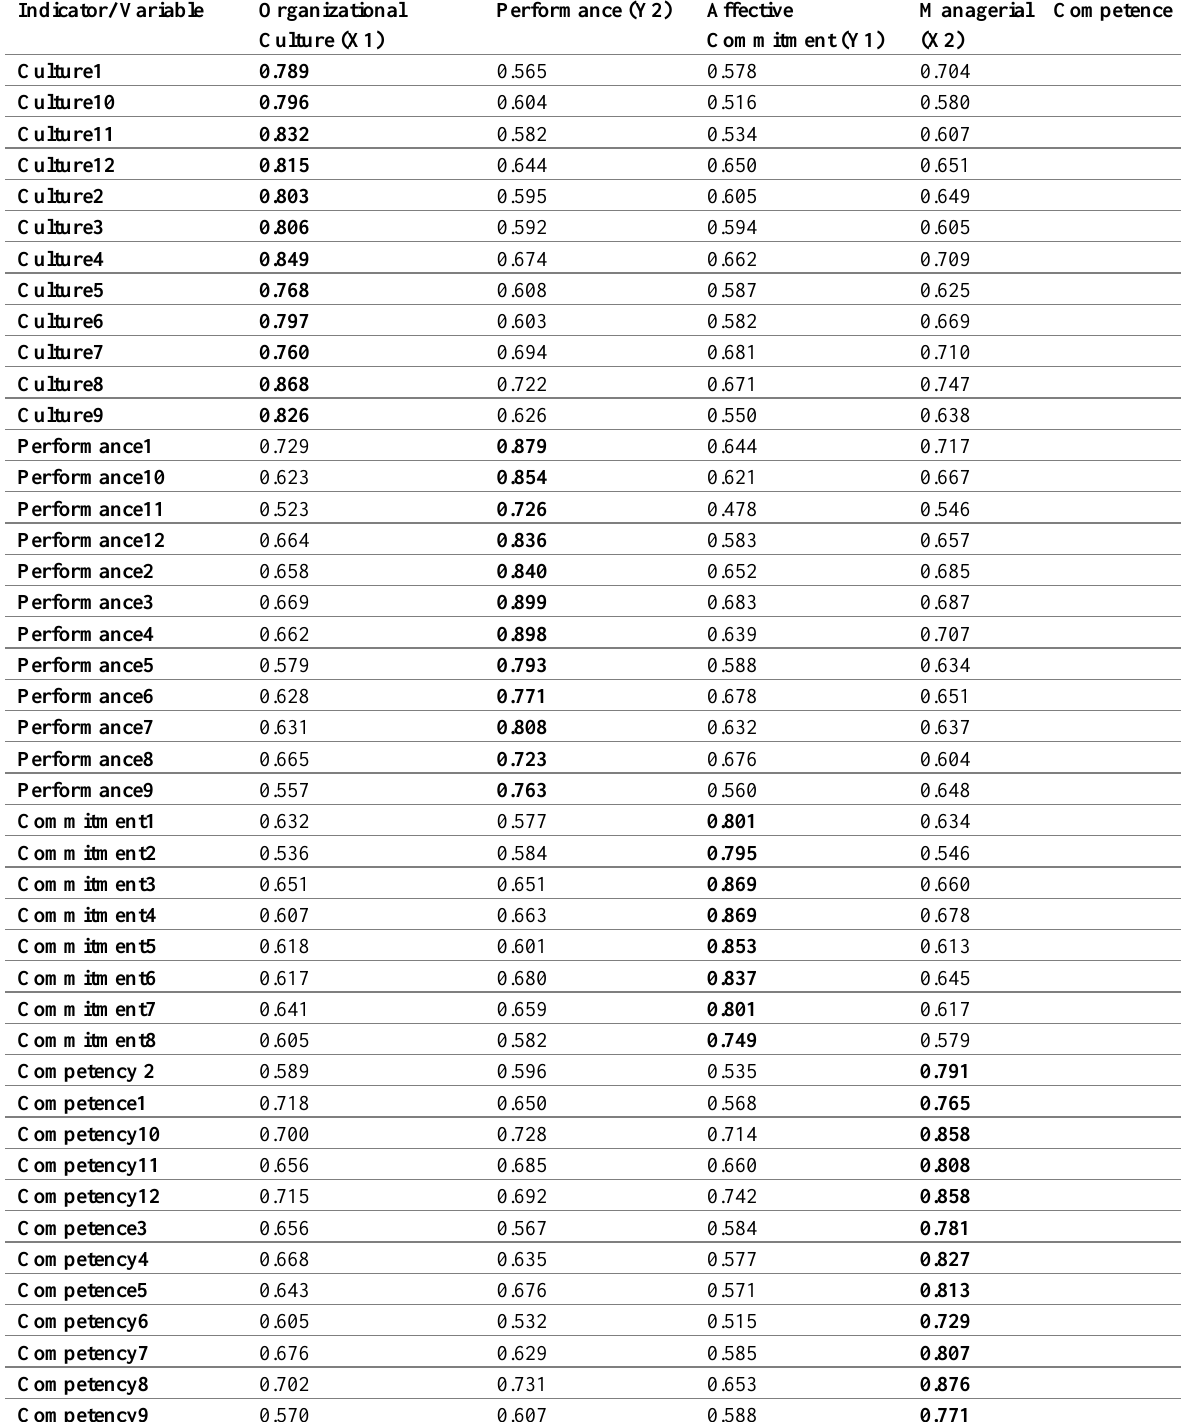
Table 16: Cross Loading